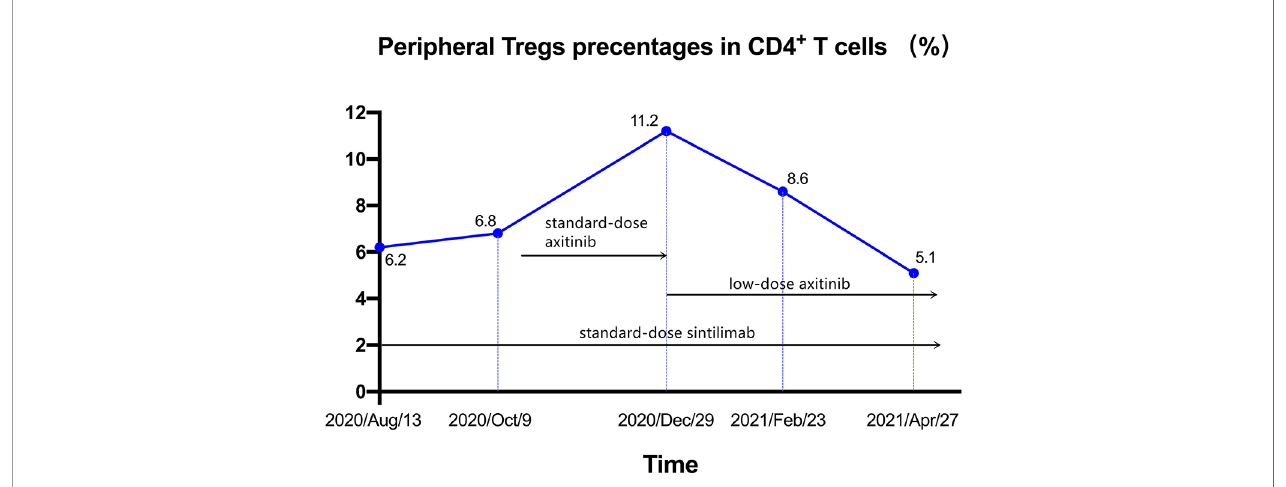
FIGURE 3 | Changes of peripheral Tregs percentages in CD4 + T